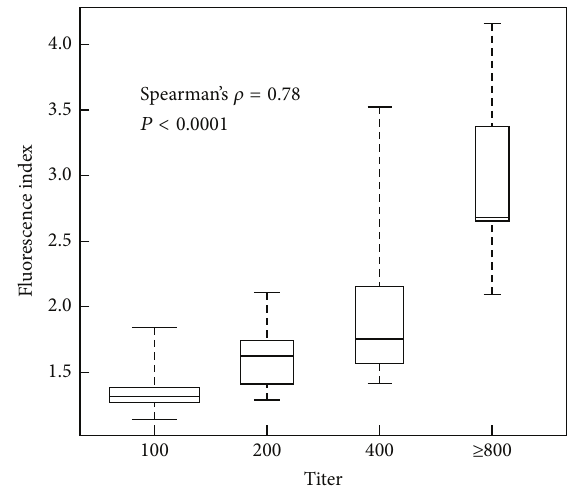
Figure 5: Correlation between fluorescence index and ANA titer. Calculated indices from patients with ANA positive speckled pat- tern ( 𝑛 = 87 ) were plotted as a function of the endpoint titer . The box plots show the median value and range from the first to the third quartile. The whiskers extend between the maximum and the minimum indices. There is a correlation between the fluorescence index and the fluorescence endpoint titer (Spearman’s 𝜌 = 0.78 , 𝑃 < 0.0001